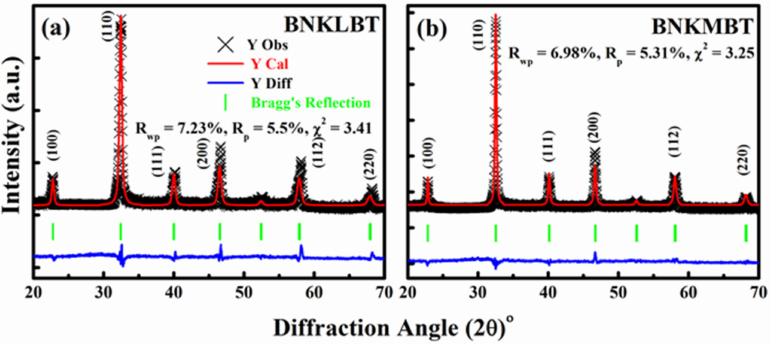
Figure 2. Rietveld refinement of XRD data of ( a ) BNKLBT, and ( b ) BNKMBT ceramics using FULL- PROF software to analyze